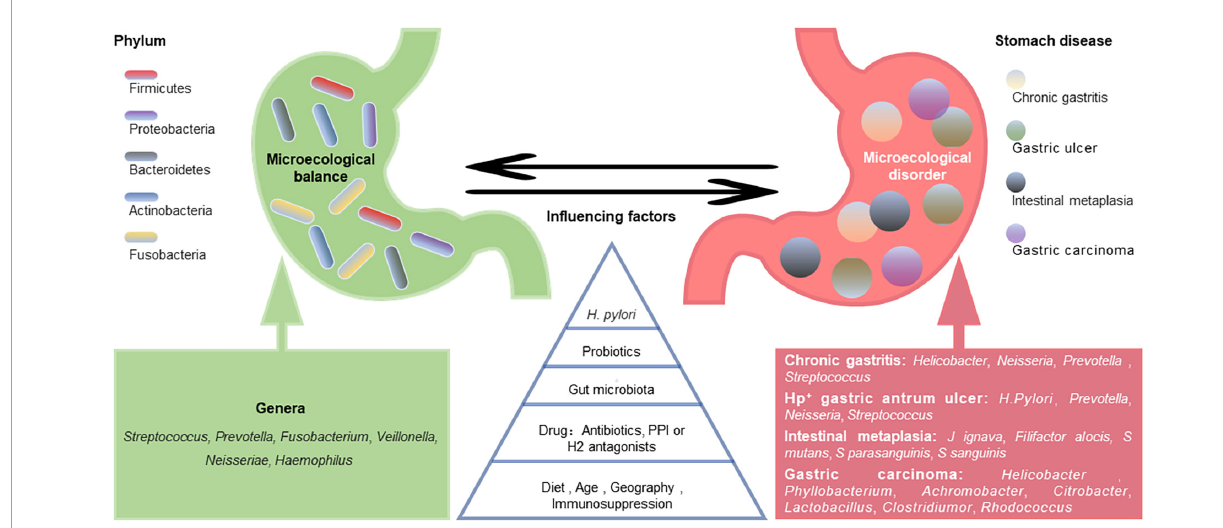
FIGURE1 Gastric microecological imbalance and gastric diseases. Despite the differences among individuals, there are five dominant bacterial phyla in the healthy stomach, and their common dominant bacterial genera are summarized (green). The gastric microbiota is dynamically balanced and affected by many factors, such as Helicobacter pylori infection, probiotics, gut microbiota, drugs, diet, and age. Although the causal relationship between them is unclear, gastric microecological imbalances are associated with various gastric diseases (red), and some microorganism-related disorders are